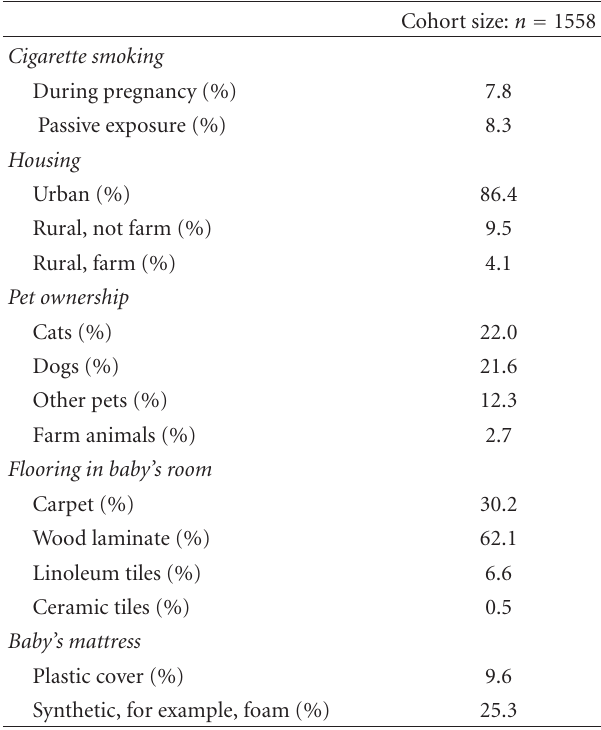
Table 2: Environmental exposures of mothers and infants in the Lithuanian birth cohort